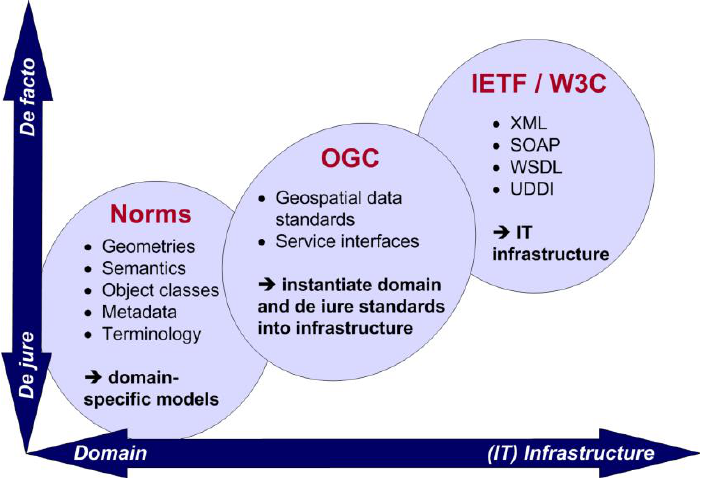
Figure 11. Standardisation Bodies Classified by Legal Bindingness and